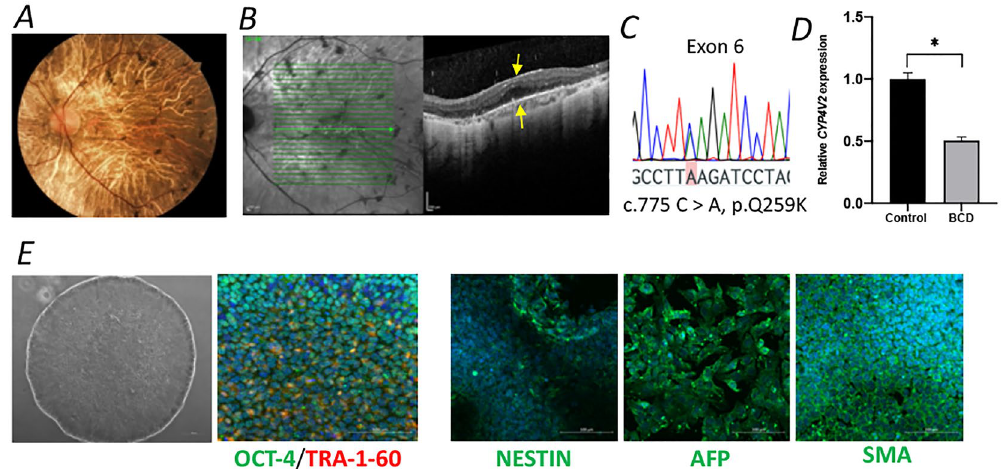
Figure 3. Diagnosis of a BCD patient and iPSCs generation. ( A ) Fundus image showing characteristic crystalline deposits. ( B ) OCT images show hyper-reflective crystalline deposits above the RPE in the BCD patients. Arrows indicate crystalline deposits. ( C ) Sanger sequencing showed a point mutation of CYP4V2 in the BCD patient (highlighted in pink). ( D ) The level of CYP4V2 mRNA in skin fibroblasts was significantly greater in the control than in the cells from the BCD patient. ( E ) Markers (including OCT-4, TRA-1–60, NESTIN, AFP and SMA ) for iPSCs immunostaining. Data are presented as mean ± SEM. * p <